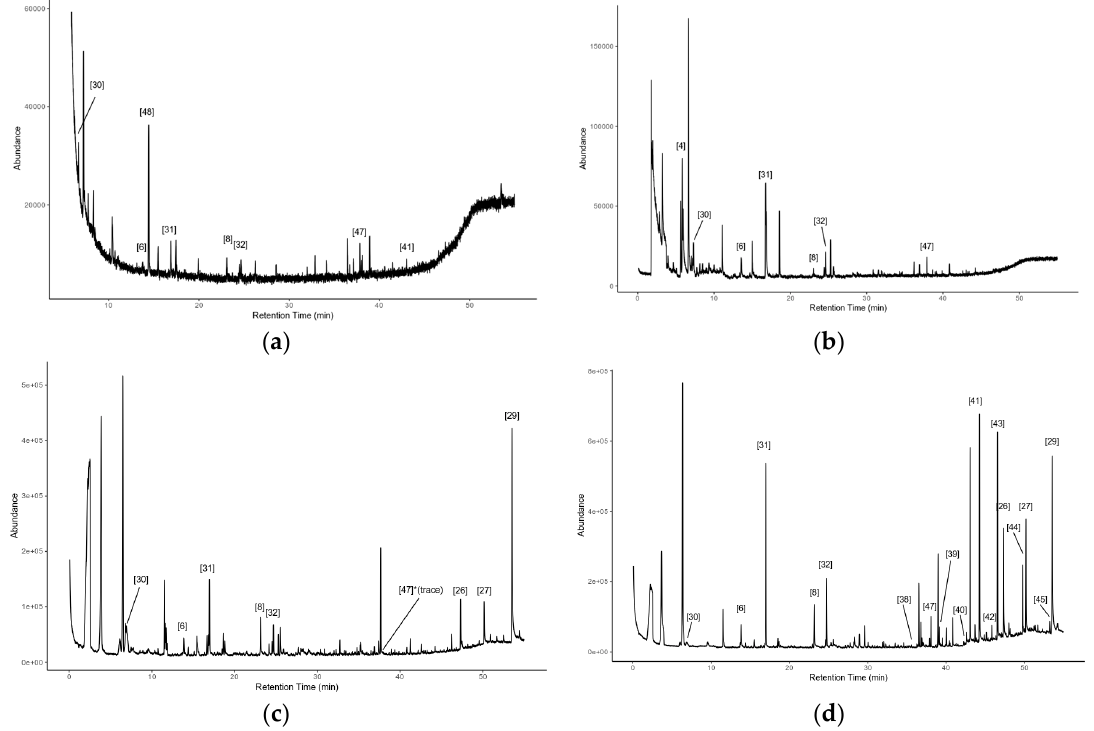
Figure A1. Representative Total Ion Chromatogram of ( a ) Solvent Assisted Flavour Evaporation (SAFE), ( b ) Solid Phase Microextraction (SPME), ( c ) Headspace Sorptive Extraction (HSSE), and ( d ) Stir Bar Sorptive Extraction (SBSE) extracts from sheep milk. Selected peaks labelled with numbers corresponding to Table 1.